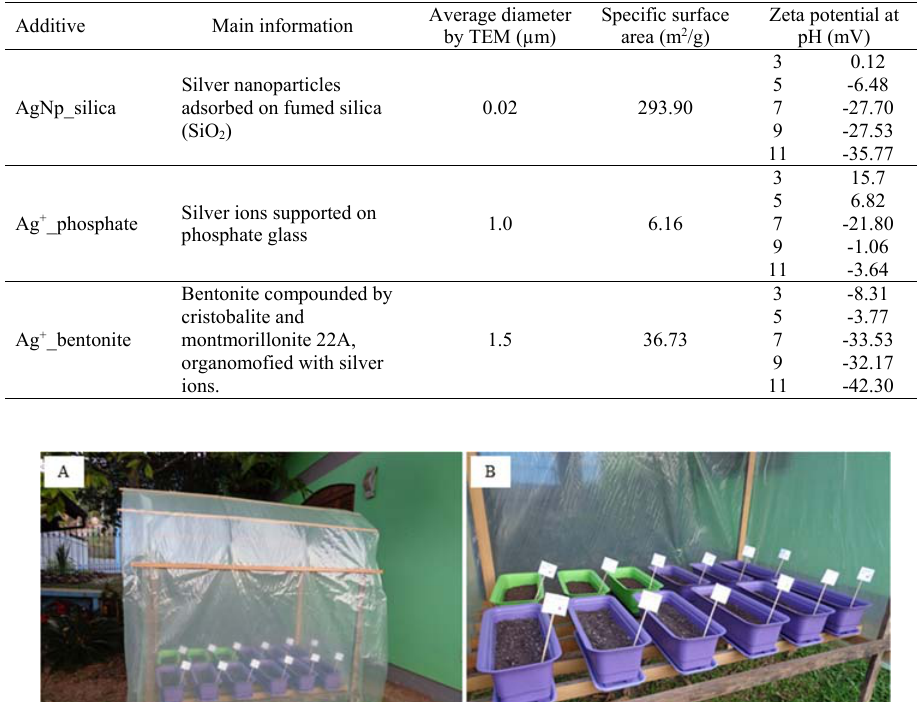
Table 1: Physical-chemical characteristics of the additives evaluated